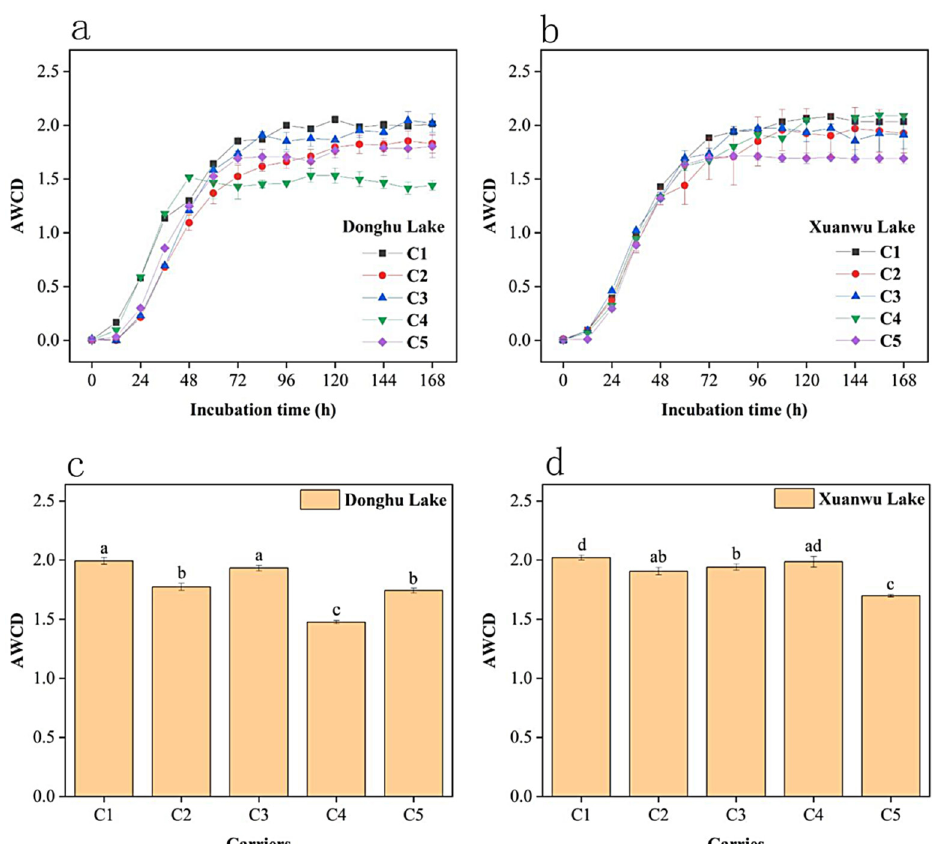
Figure 1. Comparison of metabolic patterns between five carriers with different specific surface areas (C1–C5) in two incubation sites, including Donghu Lake ( a ) and Xuanwu Lake ( b ), and five curves with different shapes of dispersion points represent the fitting curves of five carriers, respectively. Comparison of carbon sources utilization of all carbon sources between five carriers with different specific surface areas (C1–C5) in two incubation sites, including Donghu Lake ( c ) and Xuanwu Lake ( d ), and different letters, represent a significant difference at p -value < 0.05 by using one-way ANOVA (comparison of biofilm samples from the same station).